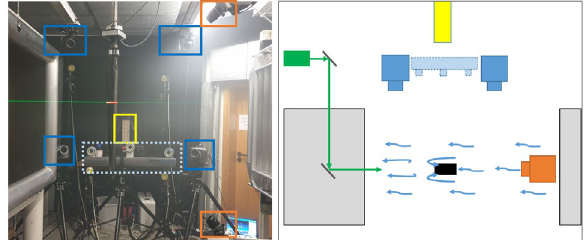
Figure 5. Left: Measurement setup in the wind tunnel. Right: Schematic top view of the experimental